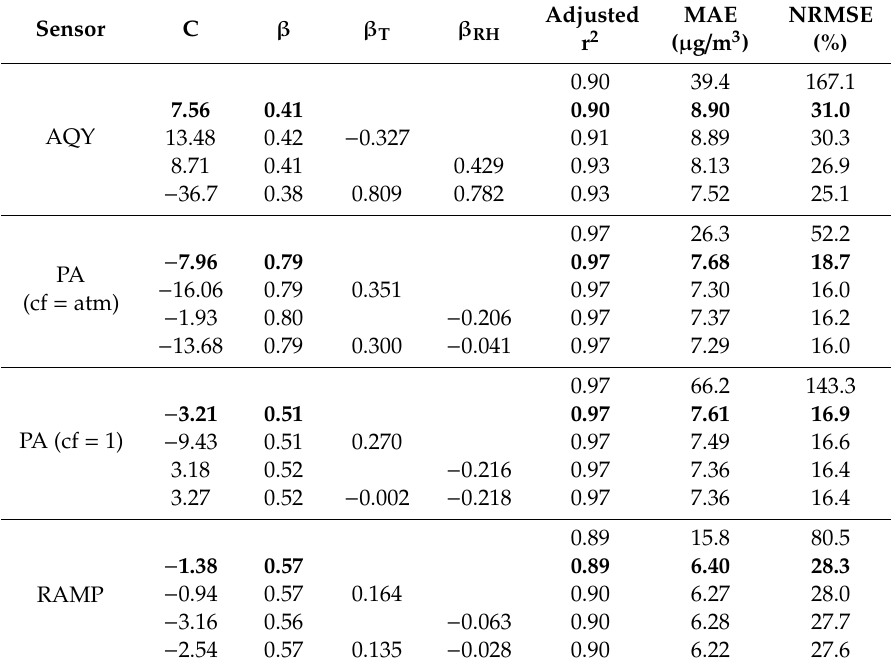
Table 6. Smoke correction linear regression parameters a , adjusted r 2 , MAE, and NRMSE. Optimal smoke correction in